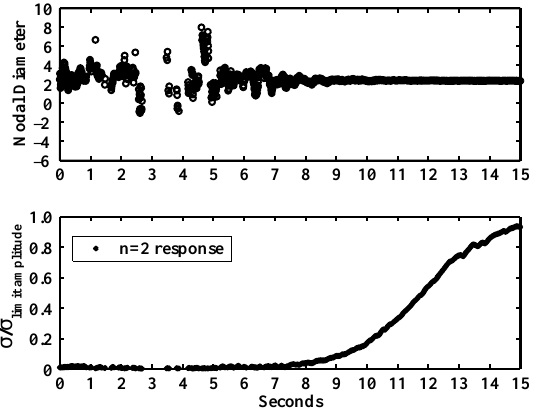
Fig. 11. Cross-power spectral analysis of strain gages 17 and 18 as the fan is back-pressured into flutter.